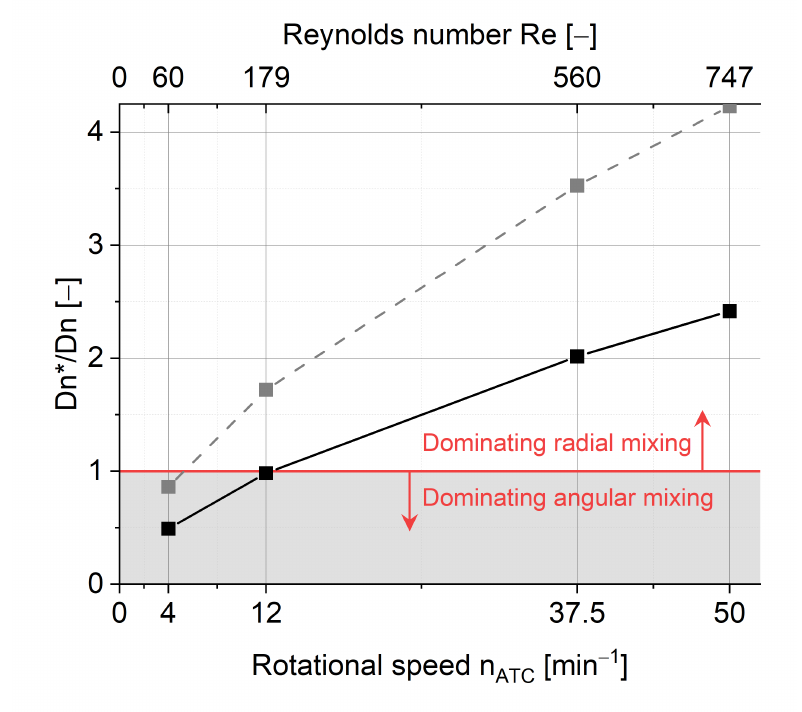
Figure 10. Rotational speed n ATC and ratio of Modified Dean number Dn ∗ to Dean number Dn for filling degree (cid:101) = 0.25 (solid black line) and (cid:101) = 0.35 (dashed gray line). Reynolds number Re is calculated for water as liquid